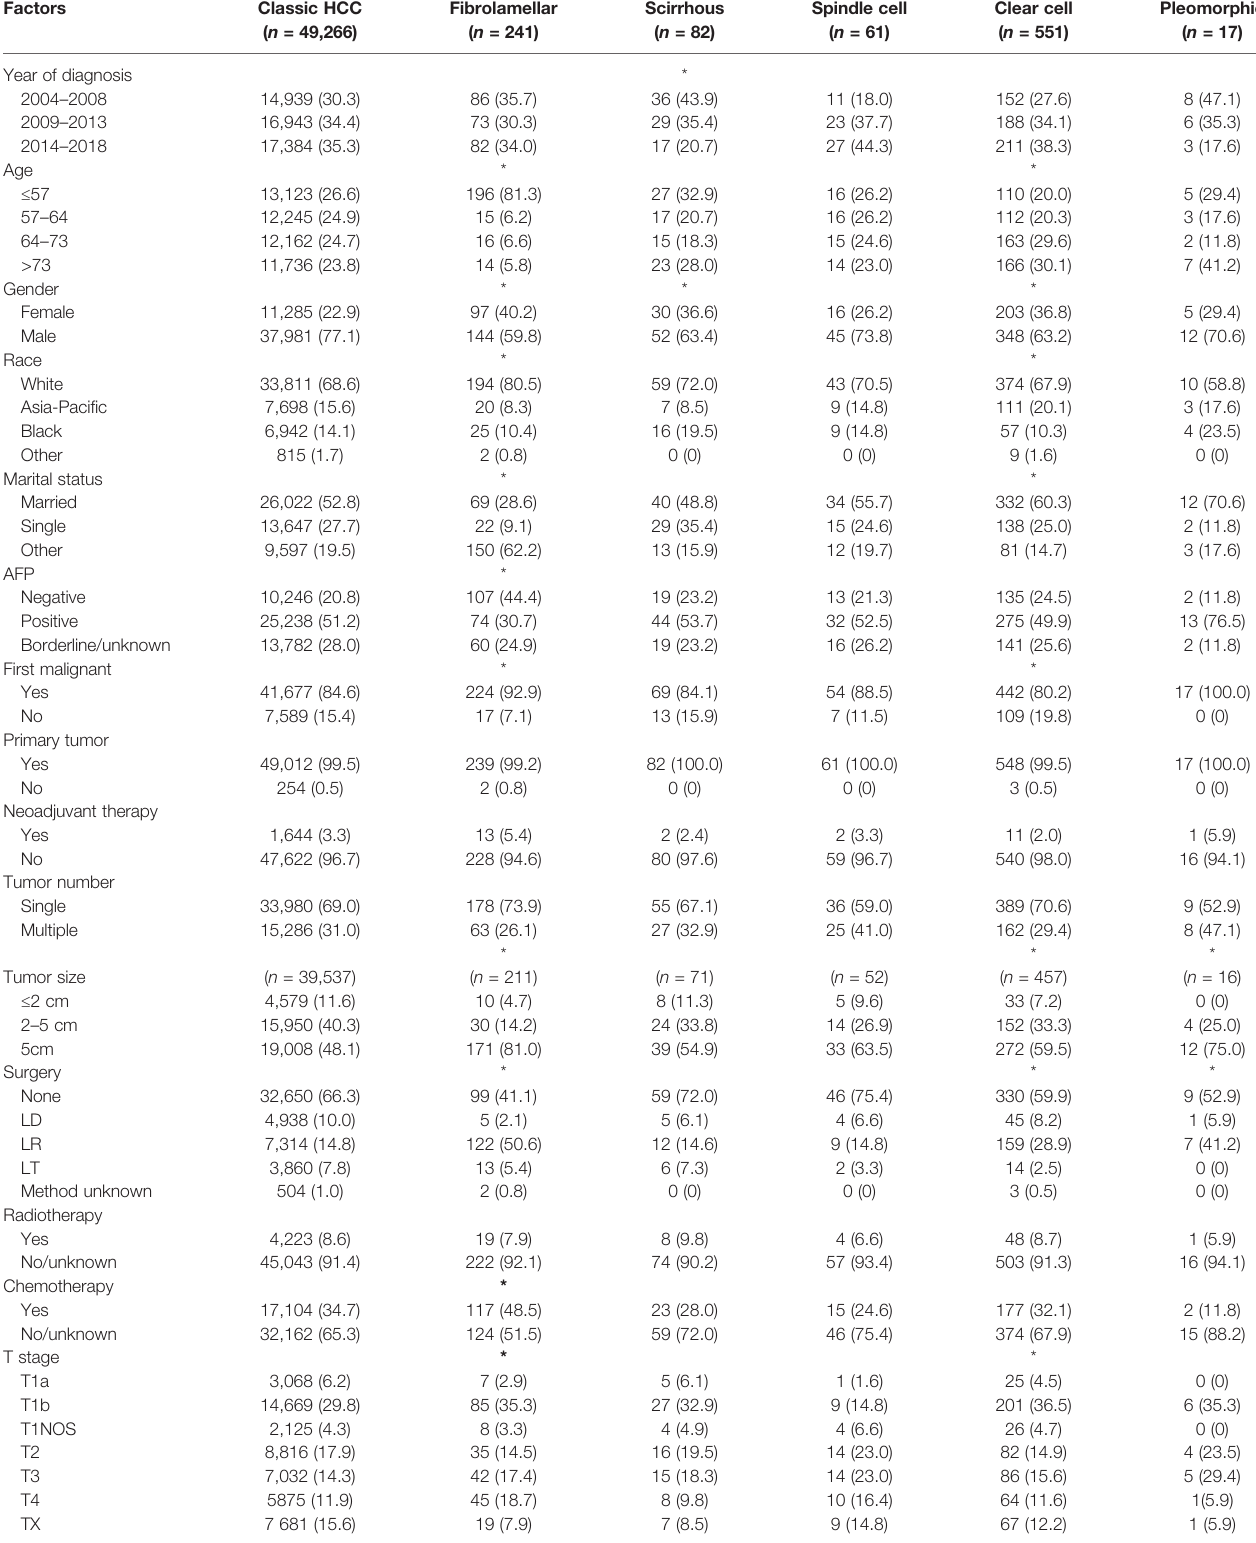
TABLE 1 | Baseline characteristics of patients with different pathological subtypes of HCC.